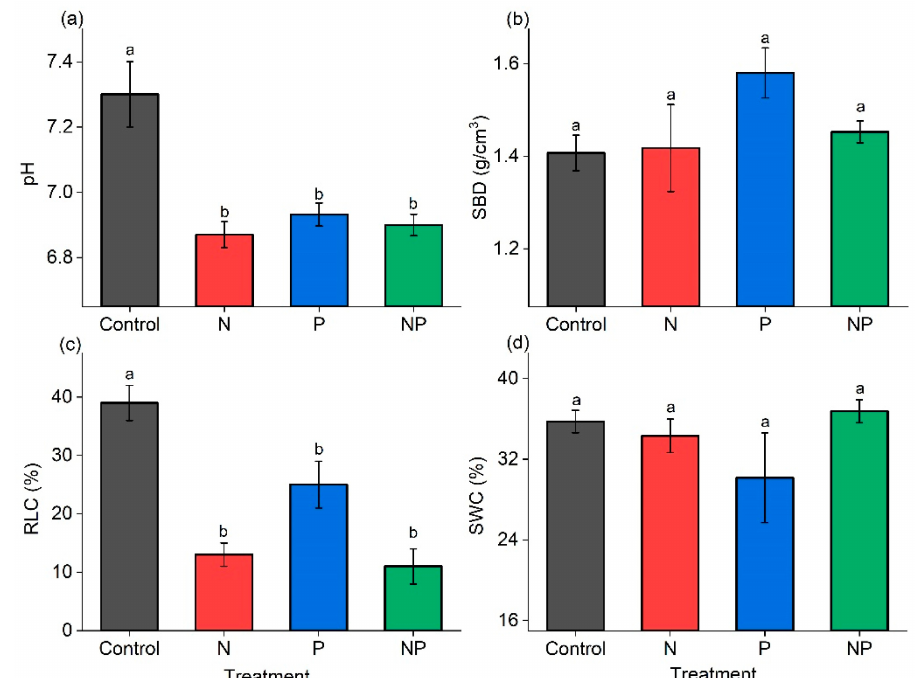
Figure 2. Effects of nitrogen and phosphorus addition on abiotic factors (M ± SE, n = 5), including ( a ) soil acidity and alkalinity (pH); ( b ) soil bulk density (SBD); ( c ) relative light conditions (RLC); ( d ) soil water content (SWC). Different letters indicate that the same index has significant differences between different treatments ( p < 0.05). Abbreviations: Control, the control without any nutrient addition; N, N-alone addition; P, P-alone addition; NP, N and P together addition.